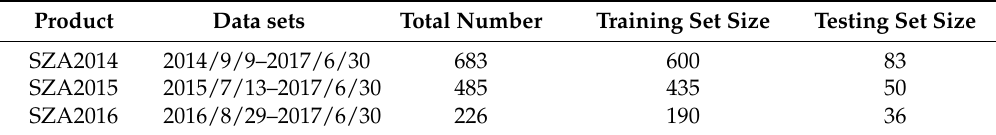
Table 9. Data sets for three additional carbon emission allowance products.